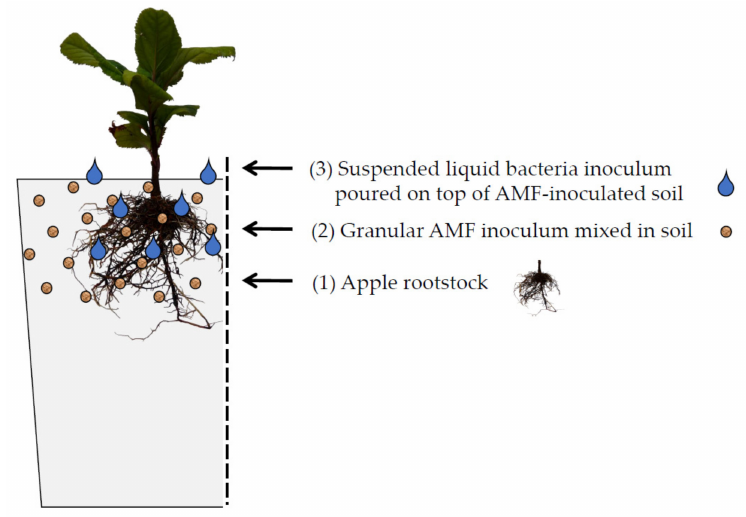
Figure 2. Formalised composition of AMFbac treatment in planting hole at time of planting. Sampling Design for Arbuscular Mycorrhiza Strains and Bacterial Strains (AMFbac) AMFbac Pot experiment